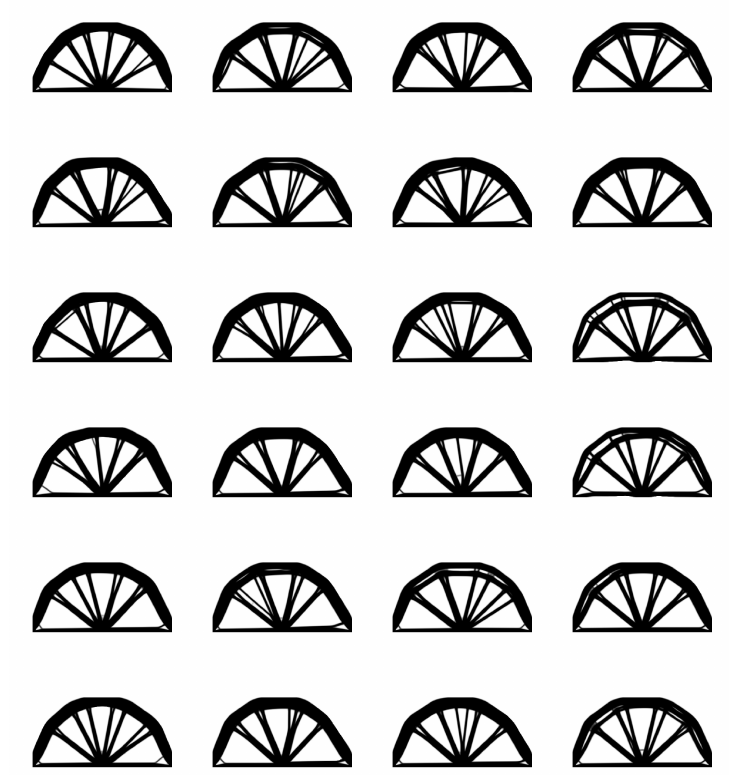
Figure 12. Results for test example